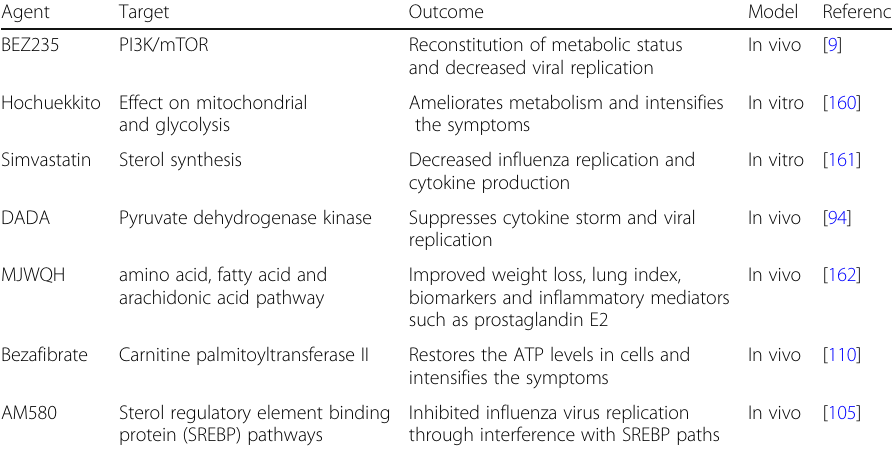
Table 1 Characteristics of some metabolic pathway blockers in influenza infection Agent